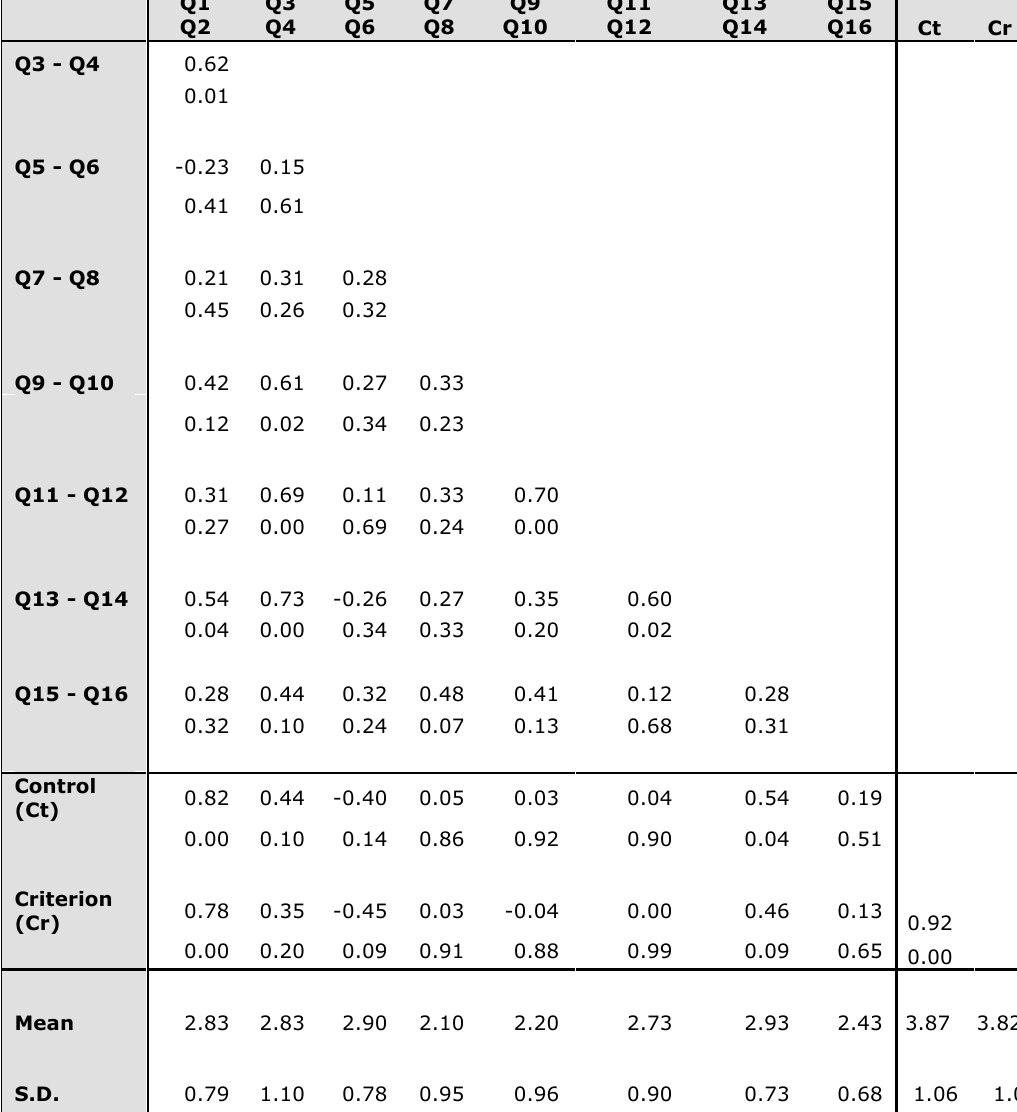
Table 2. “Summary of Correlations, Means and Standard Deviations for Study Variables”. Table 3 represents the results of multiple regression analysis. The results indicate that only Q1 – Q2 (memorizing via organized documentation) is a significant predictor of process improvement (t = 3.17, p = 0.019). ANOVA calculations presented in Table 4 shows that regression model is significant (F-value = 3.31, p = 0.081). The remaining predictor variables did not show a significant relationship with the criterion variable (p > 0.1). The normal probability plots, the fitted